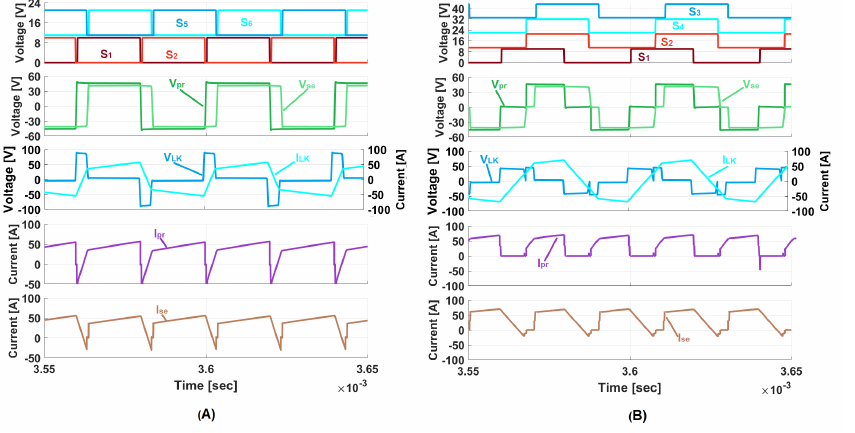
Figure 14. Simulated waveforms obtained imposing a charging current set-point of 40 A to the model shown in Figure 8 using the algorithm SPS ( A ) and (TPS) ( B